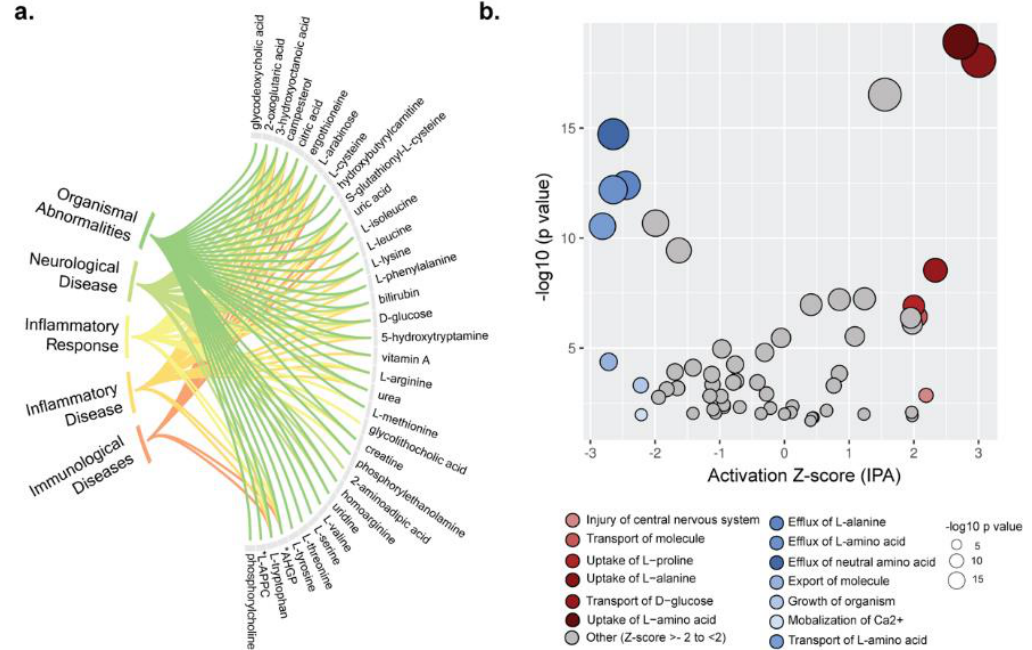
Figure 4. Metabolome annotation and biofunction analysis. ( a ) Metabolome annotation results obtained from ingenuity pathway analysis (IPA). The figure visualizes the most significant biological functions ( p < 0.05) and corresponding metabolites. ( b ) Pathway enrichment analysis results from IPA for metabolome data. IPA generated activation z -scores in the x -axis and p -values in the y -axis. Bubble sizes are relative to p -values. A negative z -score implies significant downregulation of the pathway and vice versa.